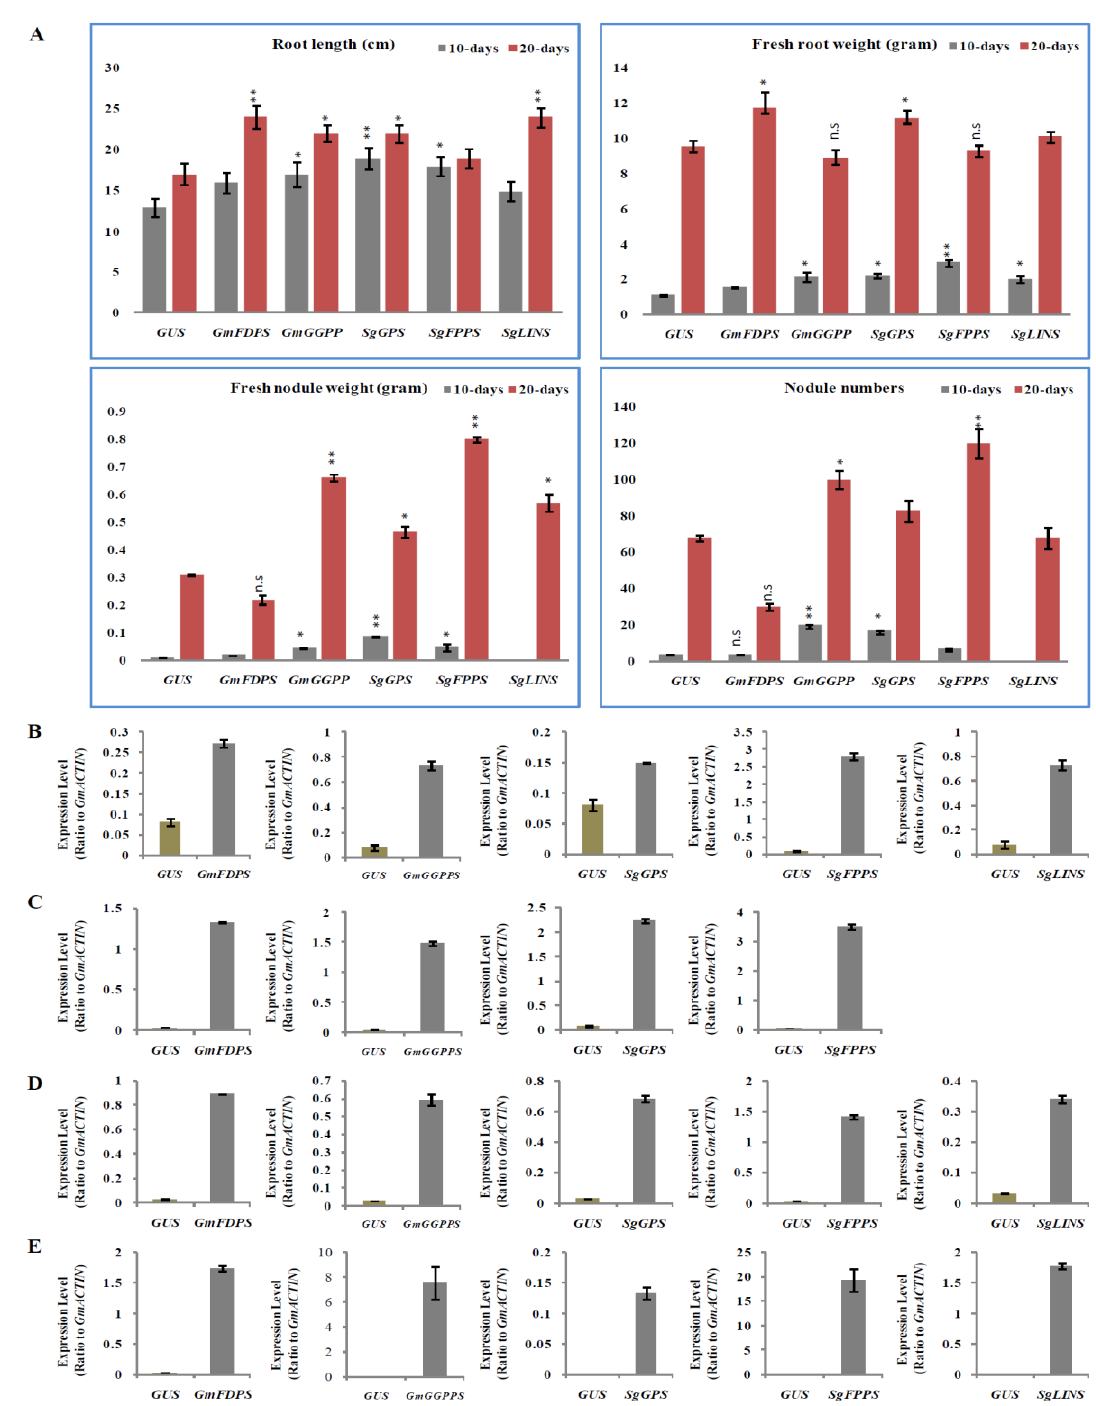
Figure 4. Effects of terpenoid synthesis gene overexpression on root growth and nodule development at 10 and 20 days of rhizobia inoculation. ( A ) In vivo root length (cm), fresh root weight (gram), fresh nodule weight (gram) and nodule numbers, were examined ( n = 10–12). Blue and red columns represent the effect of gene overexpression after 10 and 20 days after rhizobial inoculation. Data are presented as means ± SD and statistical significance is based on Student’s t -test (* p < 0.05; ** p < 0.01; (n.s.), not significant) with GUS-overexpressing hairy roots as the control; ( B ) Quantitative RT-PCR for in vivo hairy roots after 10days from B. japonicum (USDA110) infection. The error bars indicate the SD of three qRT-PCR biological replicates; ( C ) qRT-PCR for nodules after 10days from infection; ( D ) qRT-PCR for in vivo hairy roots after 20days from infection; ( E ) qRT-PCR for nodules after 20days from